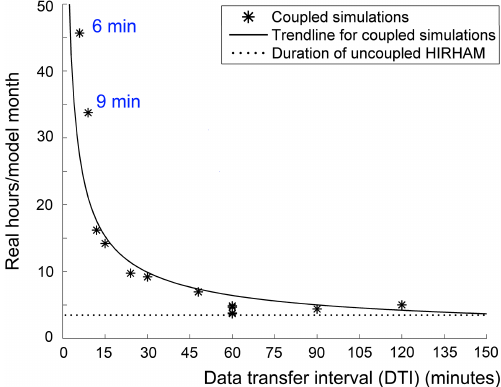
Figure 4. Model execution time in hours of wall time as a func- tion of DTI. DTI steps of 6, 9, 12, 15, 24, 30, 48, 60, 90 (eight CV runs), and 120min were used, whereas 6 and 9min DTI values were extrapolated from unfinished runs. For comparison, the dashed line is the execution time for the uncoupled HIRHAM runs (HUV). Reprinted from Butts et al.